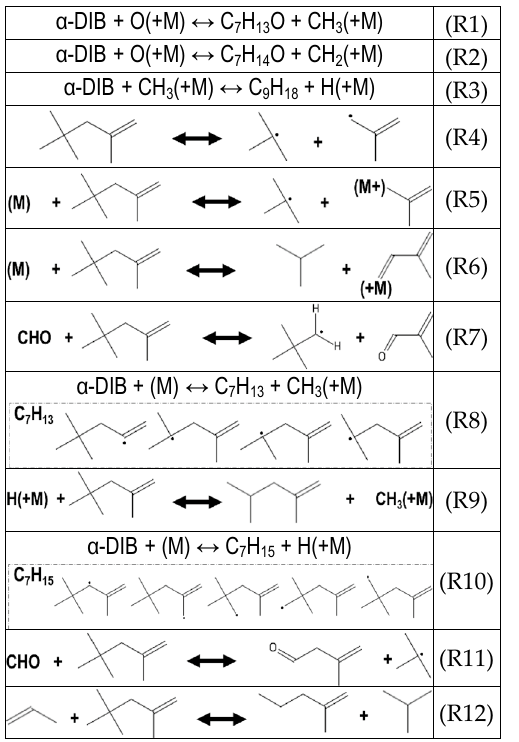
Table 4. Reactions pertinent to